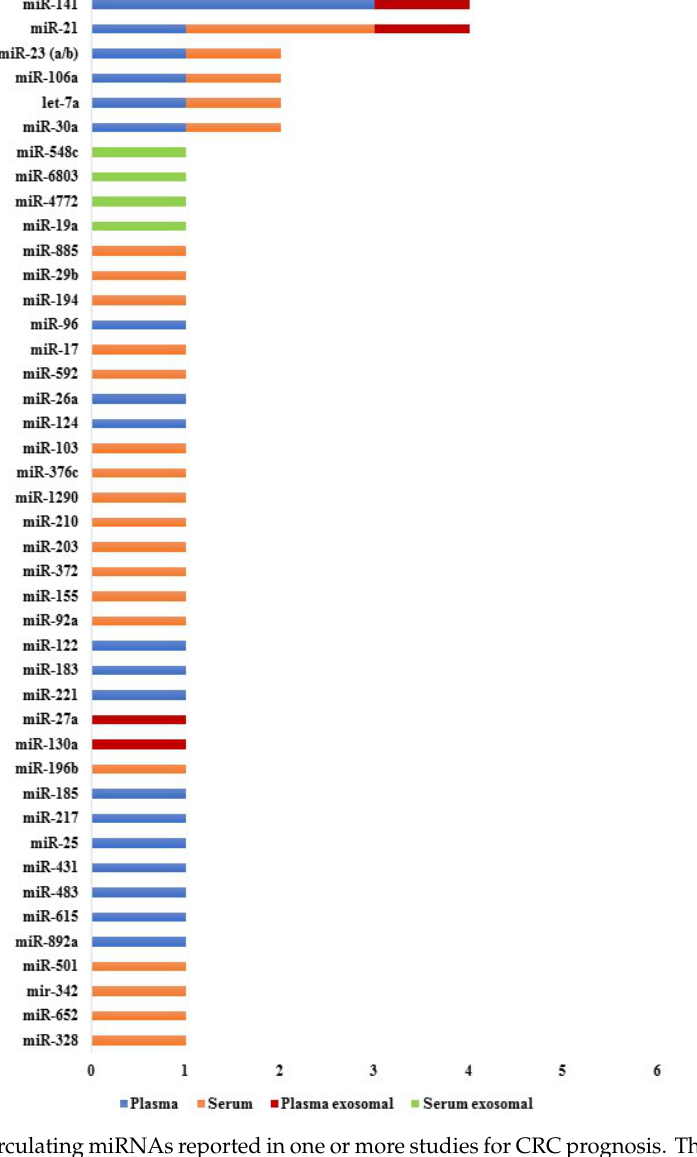
Figure 3. List of circulating miRNAs reported in one or more studies for CRC prognosis. These miRNAs were significantly associated with survival ( p < 0.05). References are provided in Table S3.